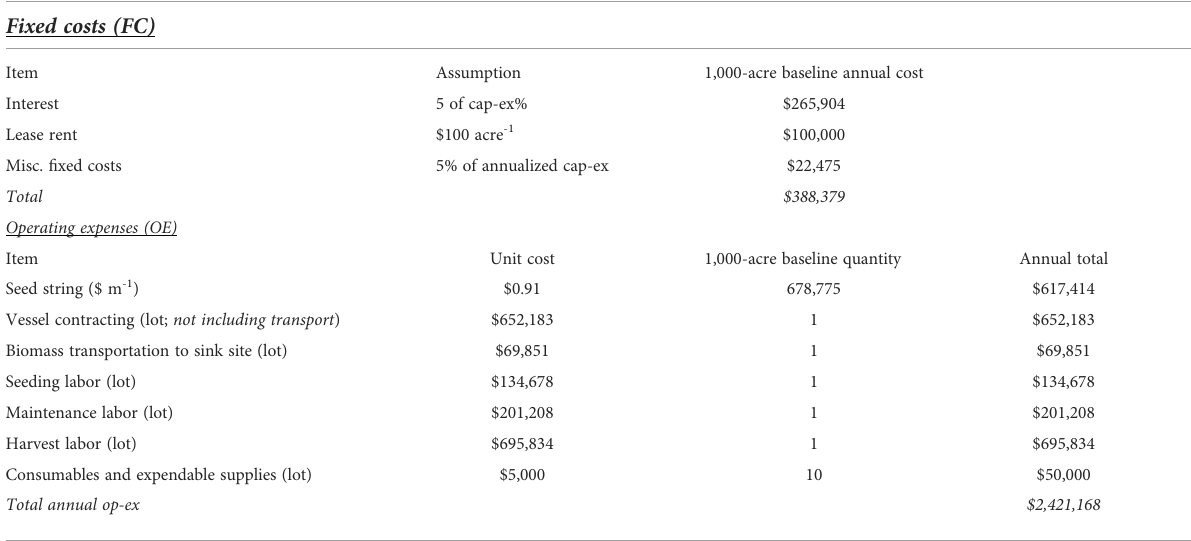
TABLE 2 Summary of costs included within Ocean Cultivation Costs ( OC ) in the baseline BTEM. OC was further decomposed into Fixed Costs ( FC ) and Operating Expenses ( OE ).